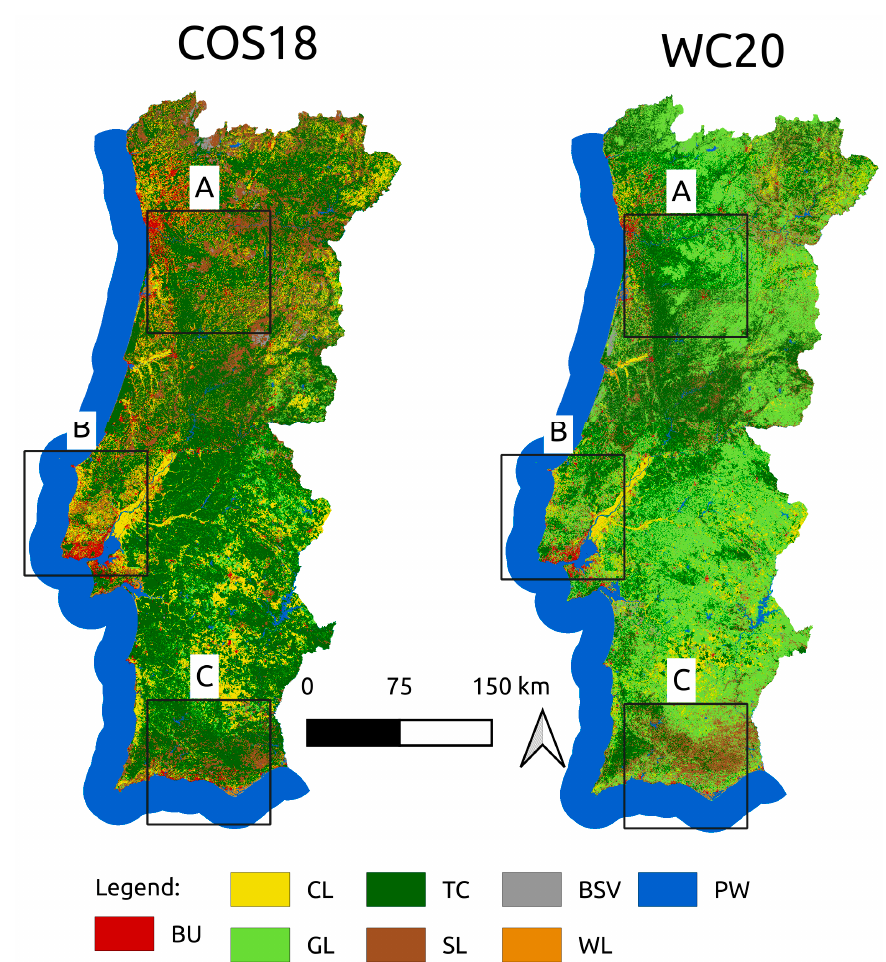
Figure 2. COS18 mapped to the WC20 nomenclature (see Section 4.1) to enable a direct comparison of both products for continental Portugal. Regions A, B and C are identified.